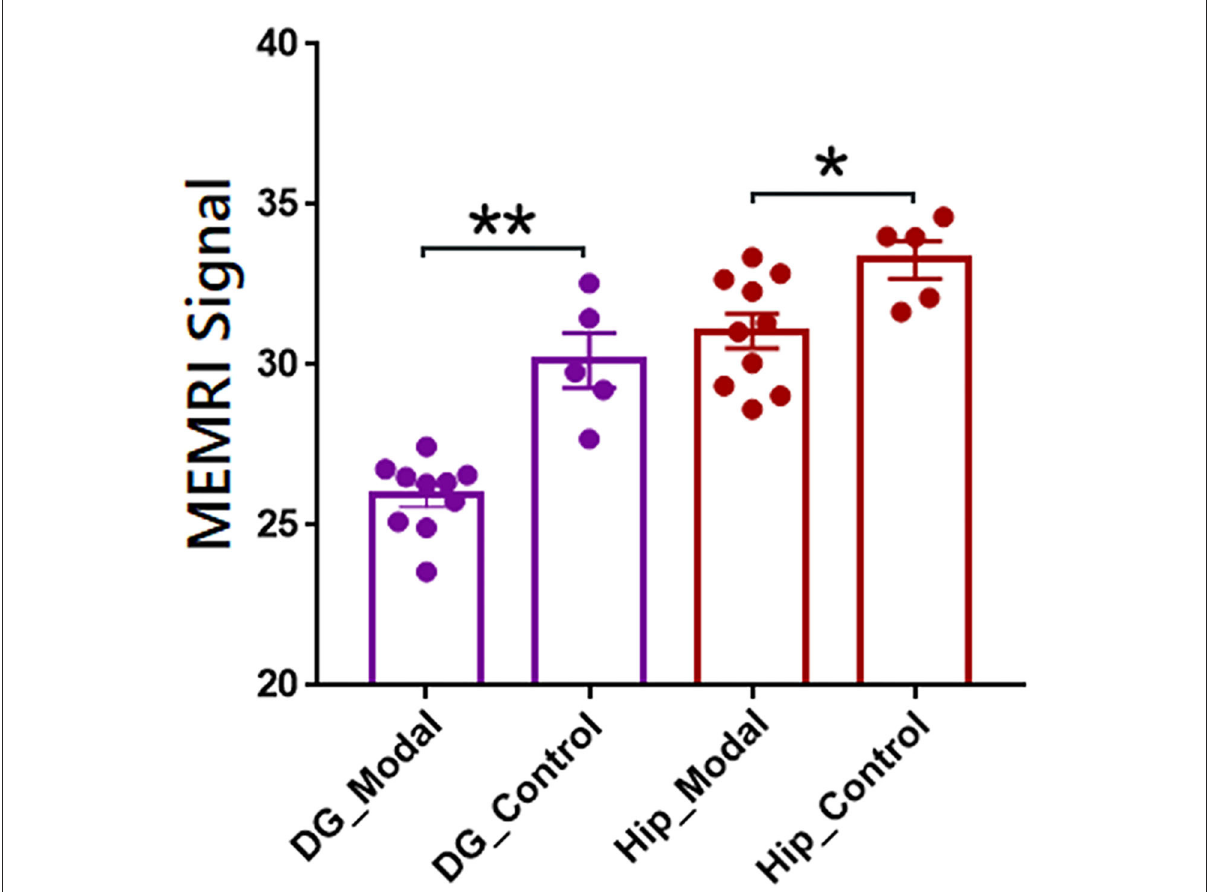
FIGURE4 Regions of interest-based quantitative analysis results of MEMRI images between modal and healthy rats. The mean MEMRI signal in bilateral dentate gyrus (purple) and hippocampus (red) were shown as mean ± SE. ** p < 0.001; * p < 0.05; DG, dentate gyrus; Hip,